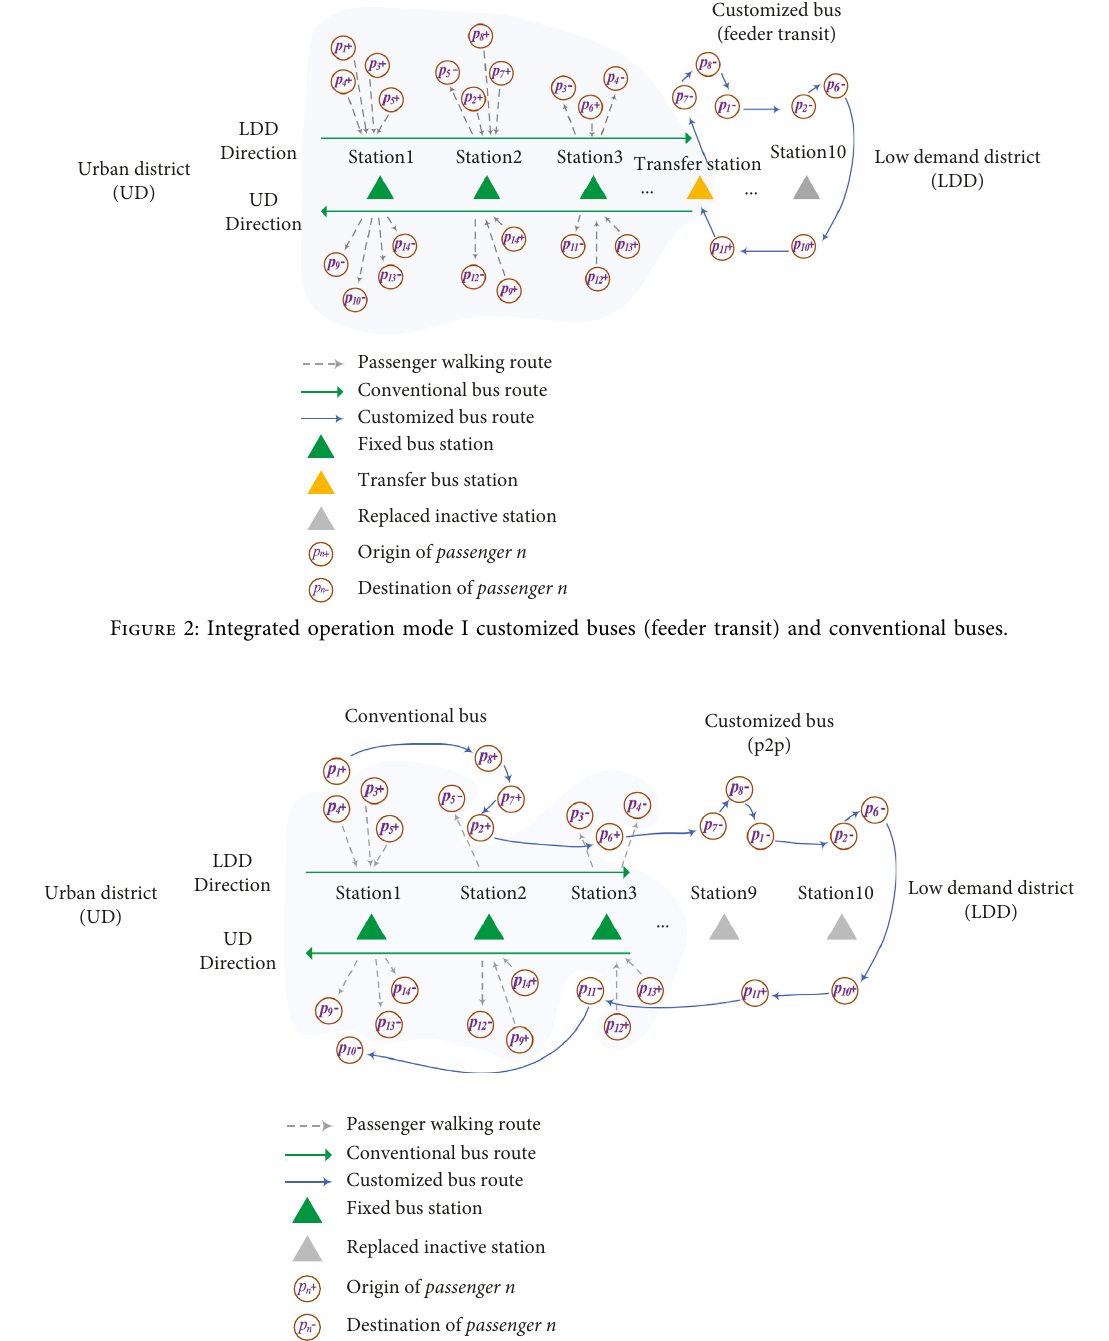
Figure 3: Integrated operation mode II: customized buses (p2p) and conventional buses.